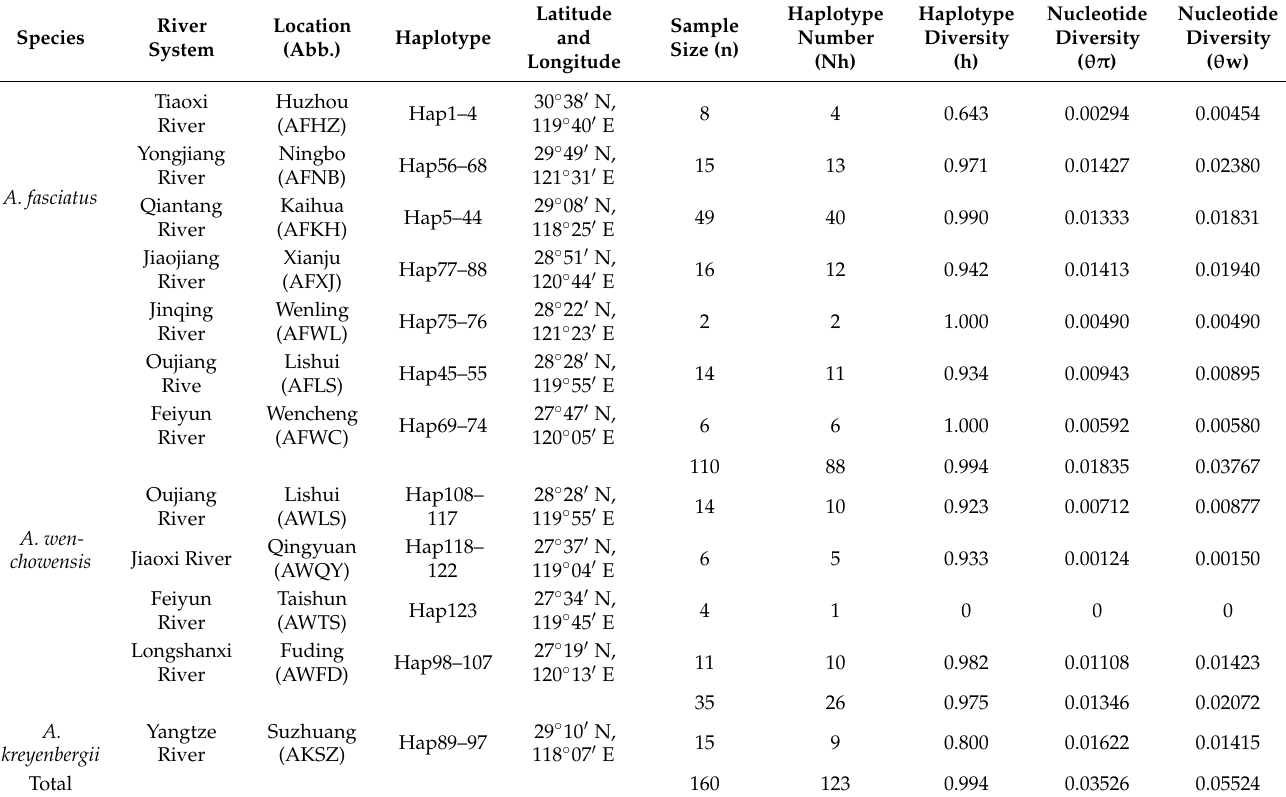
Table 1. Sample information and genetic diversity of the cyt b + D-loop region in the genus Acrossocheilus . Location